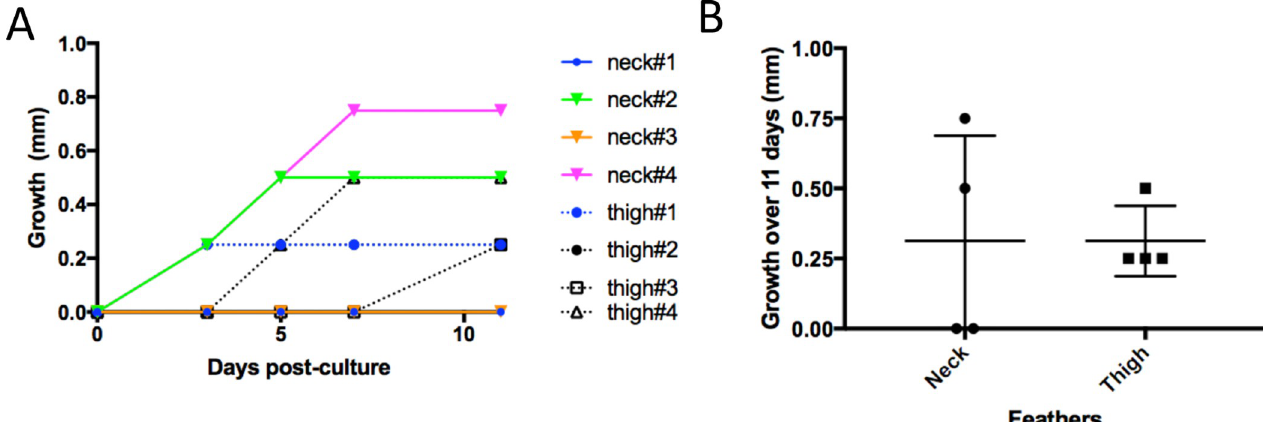
Fig 6. Growth of feathers cultivated in vitro for 11 days. The size (in mm) of 8 truncated feathers (4 from the neck and 4 from the thigh) inserted in their FF was measured after 3, 5, 7, and 11 days in culture. Note that each feather was shortened above the skin level before the dissection process. (A) Growth kinetic of individual feathers. Only the gain of growth over time is shown. Except for two feathers from the neck, all feathers weakly grew in length. (B). Total growth by origin (neck or thigh) over 11 days of cultivation.